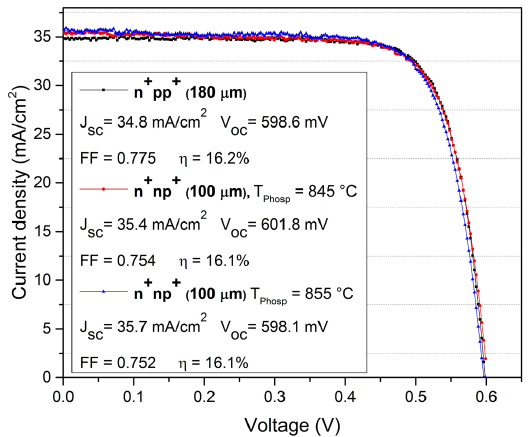
Figure 4. Current density as a function of the voltage of the n + np + thin cells and n + pp + thick standard device. T diffusion